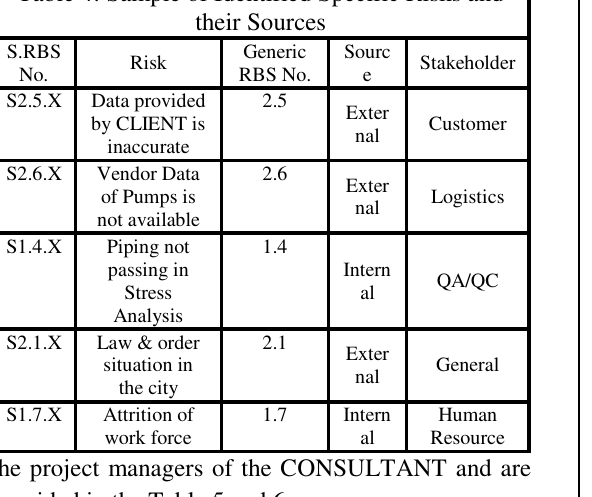
Table 4: Sample of Identified Specific Risks and